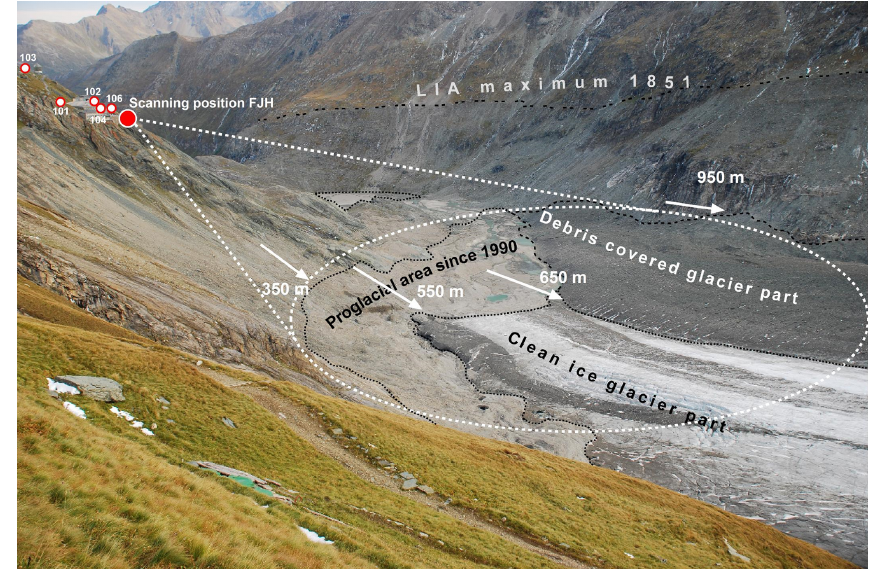
Figure 5. Scanning configuration at the Pasterze Glacier terminus area from the scanning position, Kaiser-Franz-Josefs-Höhe (FJH). Dots near the scanning position represent the location of the reference points. Numbers near the arrows indicate the distance from the scanning